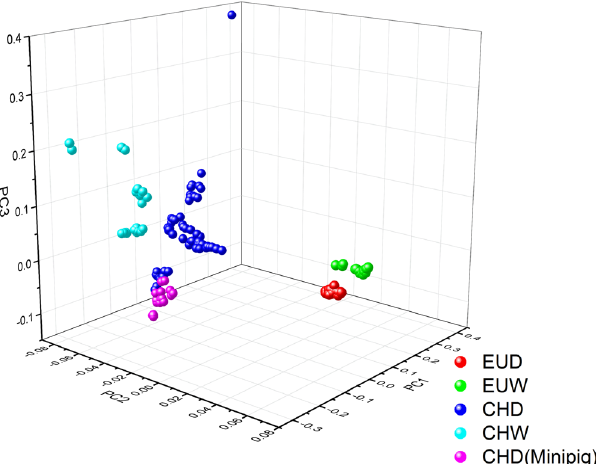
Figure 1. Results of PCA using whole-genome SNP data. Three-way PCA plot of 242 individuals (a Ukraine boar and the Outgroup were excluded in the graph). PC1, principal component 1; PC2, principal component 2; PC3, principal component